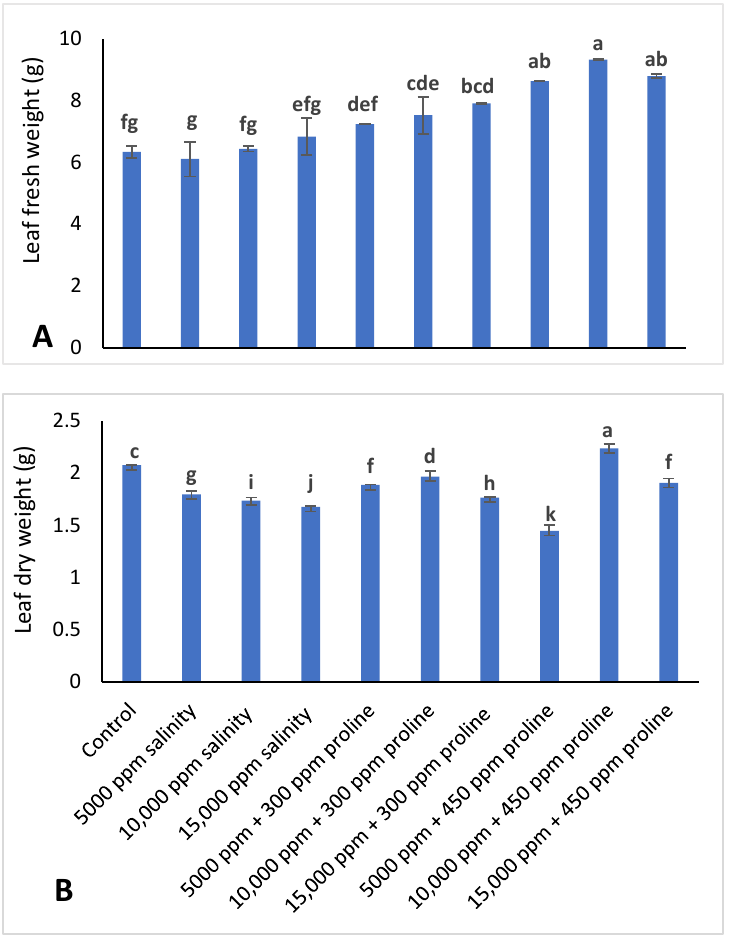
Figure 4. Effect of different levels of seawater salinity and exogenous proline at three concentrations, 0 ppm, 300 ppm, and 450 ppm, on leaf fresh weight ( A ) and leaf dry weight ( B ). Data are means of two seasons (2020 and 2021) and three replicates ( n = 3) each season. The mean values ± SE of each parameter followed by different alphabetical letters are significantly different according to Duncan’s multiple range test at p ≤ 0.05.